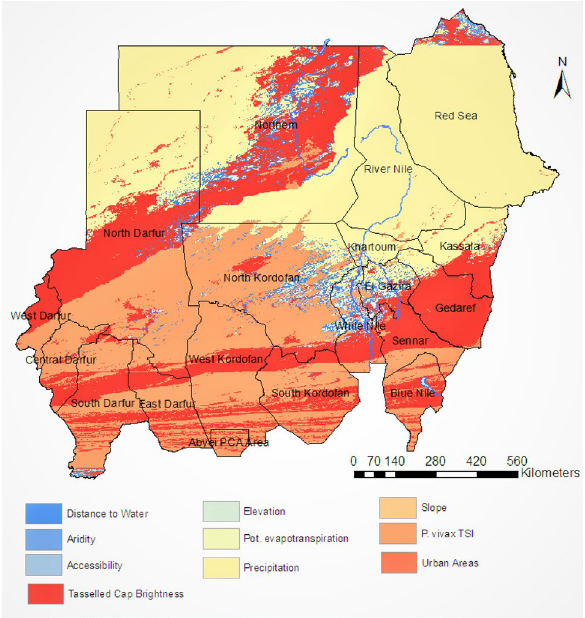
Figure 8. The most influential covariates for predicting the incidence rate of Plasmodium vivax in Sudan. These covariates are associated with leading the increase in the malaria incidence